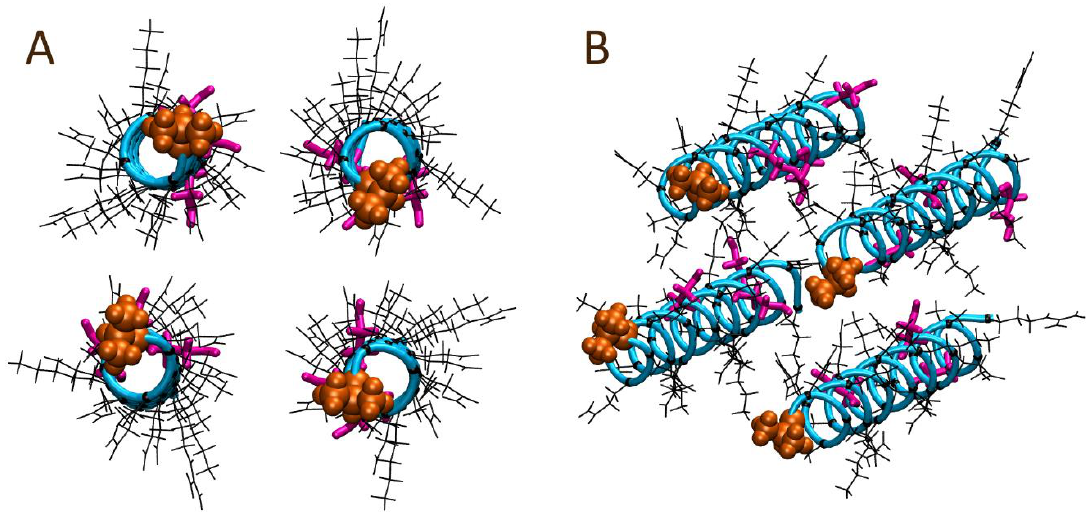
Figure 5. Starting peptide alignment for the solution bound four AR28 peptide system modelled with a head-to-head alignment: ( A ) front and ( B ) perspective views. The N-terminal alanine is shown in orange; the peptide backbone atoms are depicted as the cyan tube; Ser12, Ser20, and Ser26 sidechains are colored magenta; and all other sidechains and their respective α-carbons are shown in black.